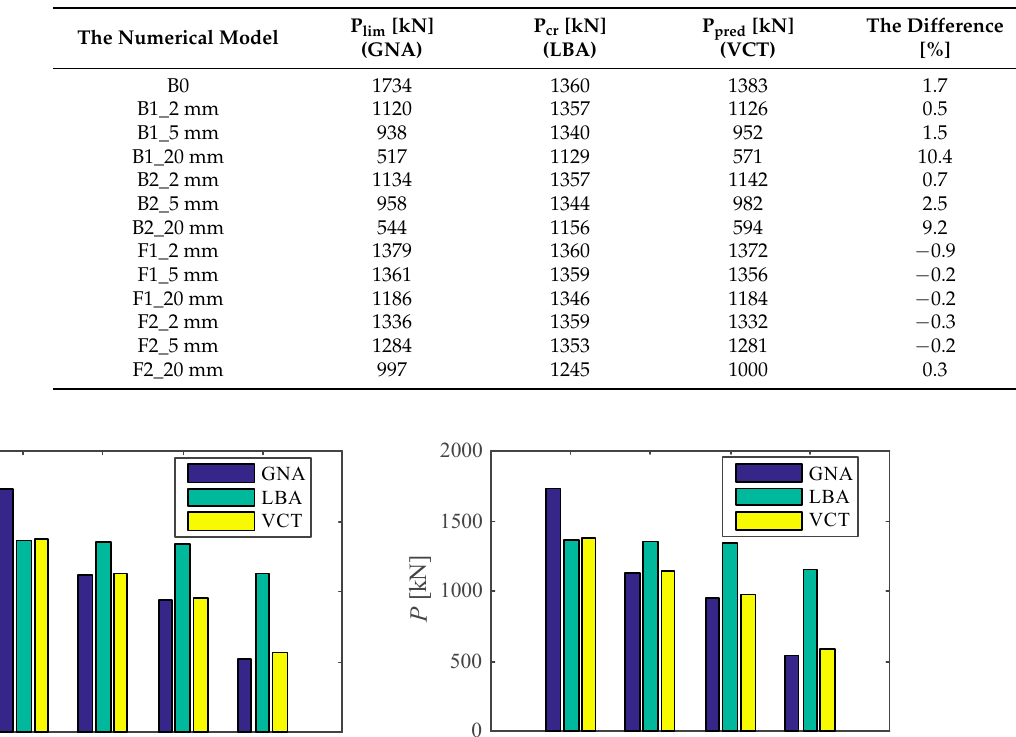
Table 1. Summary of the GNA, LBA and VCT results.